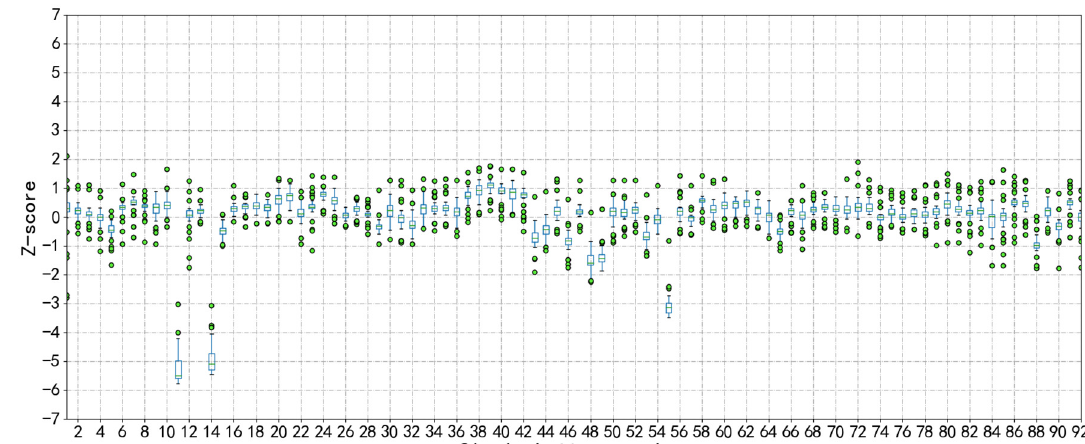
Figure 8. Box plot of Z-score of single battery voltage.